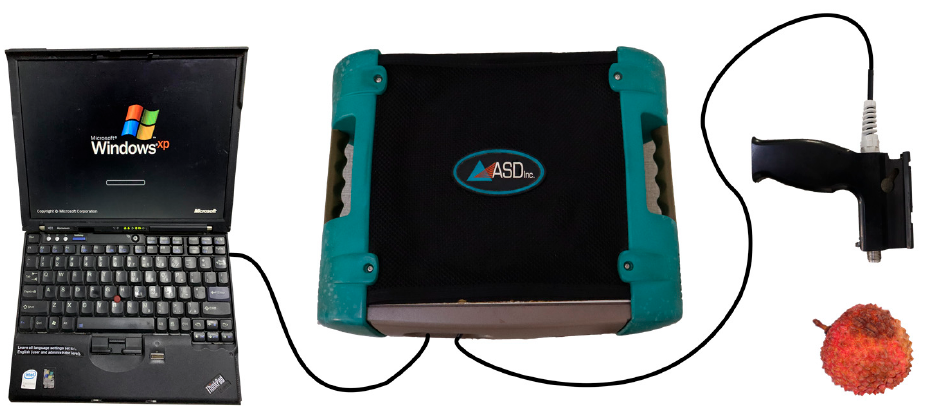
Figure 3. The process of spectral data acquisition.